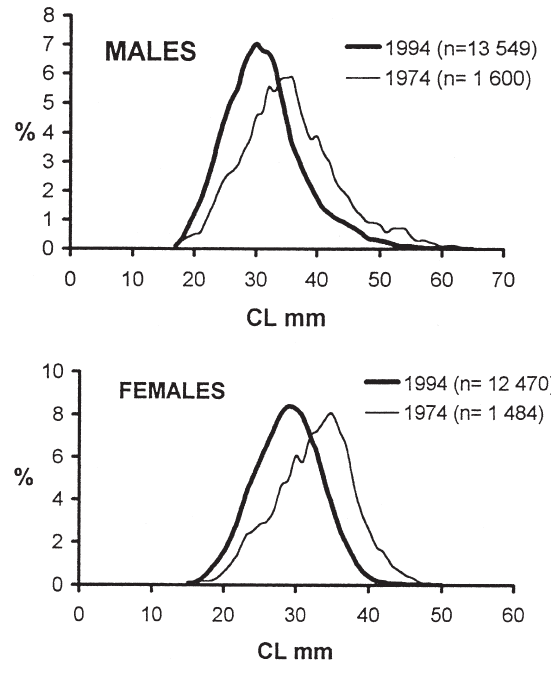
F IG . 2. – Plot of size frequencies for Norway lobster ( Nephrops norvegicus ) from samples taken in 1974 and in 1994 on the Serola Bank fishing grounds off